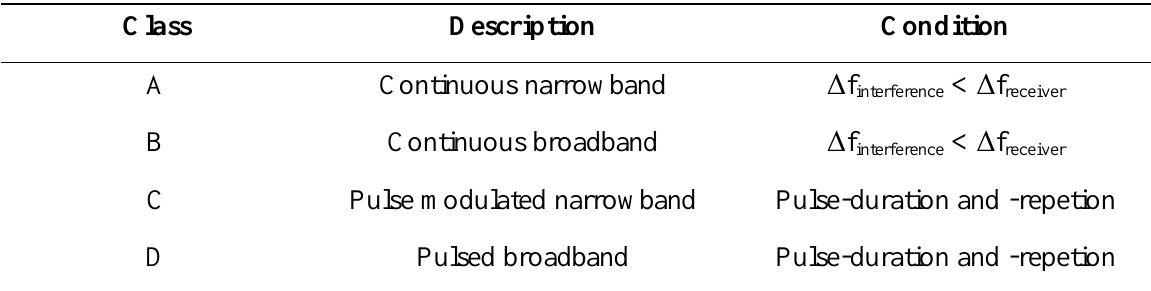
Table 1. Character of the